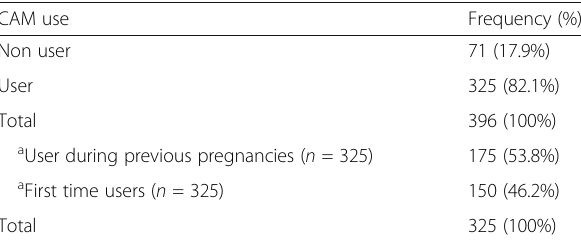
Table 2 Prevalence of CAM use among pregnant women in